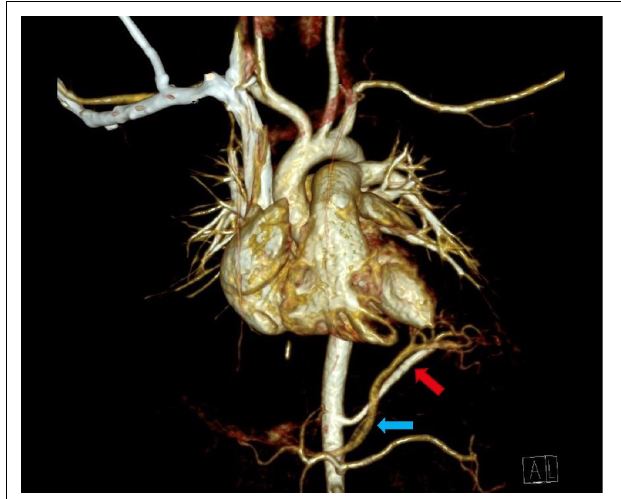
FIGURE 1 | Thoracic contrast-enhanced computed tomography scan (CECT) depicting right lower lobe hybrid lesion. Supra- and infra-diaphragmatic arteries originate from the descending aorta and the celiac trunk (blue arrows). TABLE 3 | Supra-diaphragmatic and infra-diaphragmatic origin of arterial feeders in congenital lung lesions (2–7). Supra-diaphragmatic type Infra-diaphragmatic type